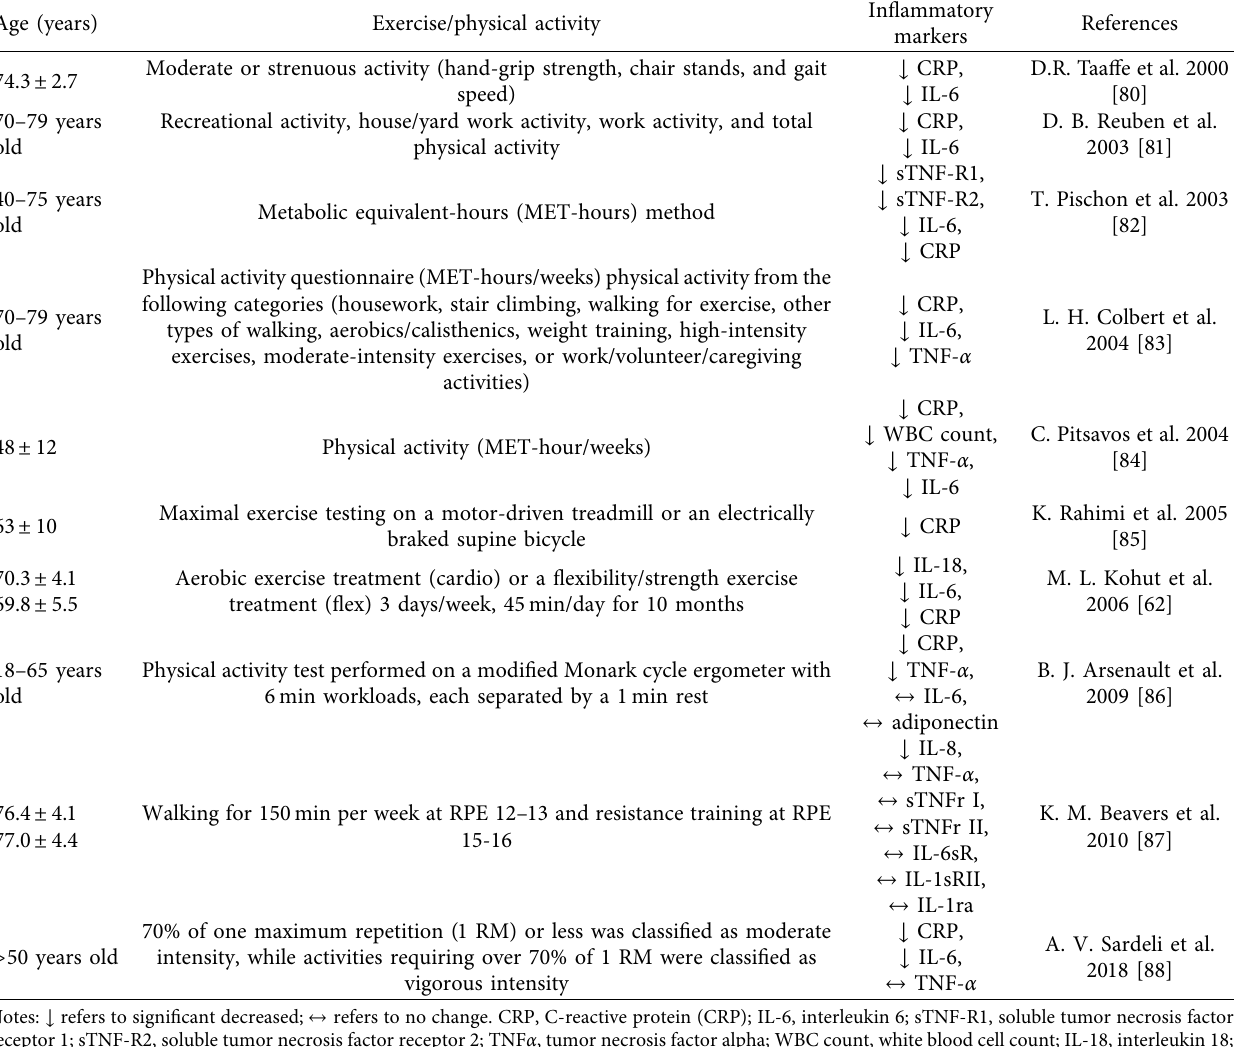
Table 1: Observational studies of the relationship between exercise and inflammatory cytokines in aging.